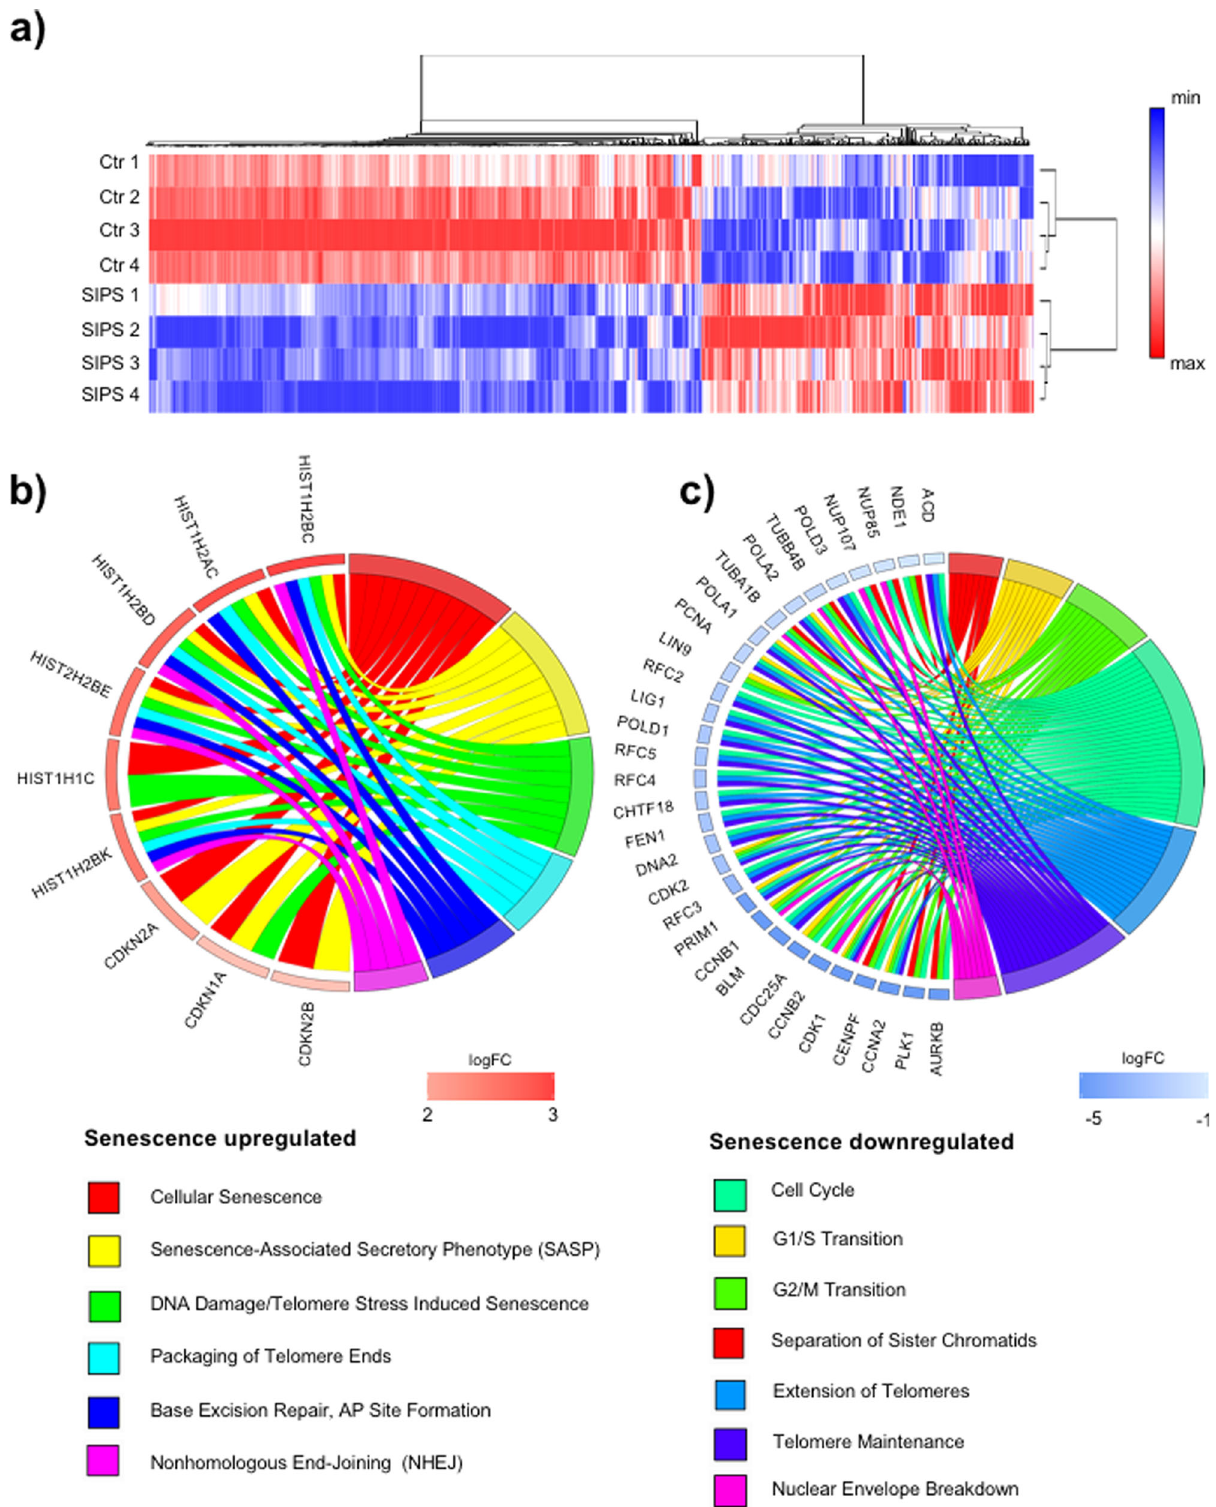
Fig. 3 SIPS induces genes associated with the telomere damage and SASP. a Hierarchical clustering and heatmap visualization of up- and downregulated genes (FDR < 0.05) after dox1d + 21d treatment (SIPS1-4) compared with control primary hVSMC lines (Ctr1 – 4). The scale bar represents gene expression difference between the maximum and minimum values for each gene of a log 2 -scale. b Chord plot for selected gene ontogeny (GO) term pathways that were signi fi cantly associated (adjusted p value < 0.05) with genes upregulated in SIPS, along with their gene members (left) within the upregulated gene set. c Chord plot for selected GO term pathways that were signi fi cantly associated (adjusted p value < 0.05) with genes downregulated in SIPS, along with their gene members (left) within the downregulated gene set, fi ltered for involvement in at least three